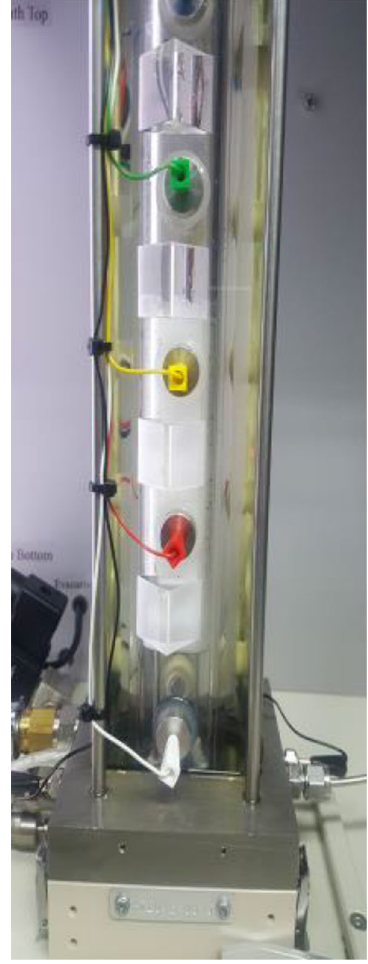
Fig. 4 A 100 foam inside glass tube